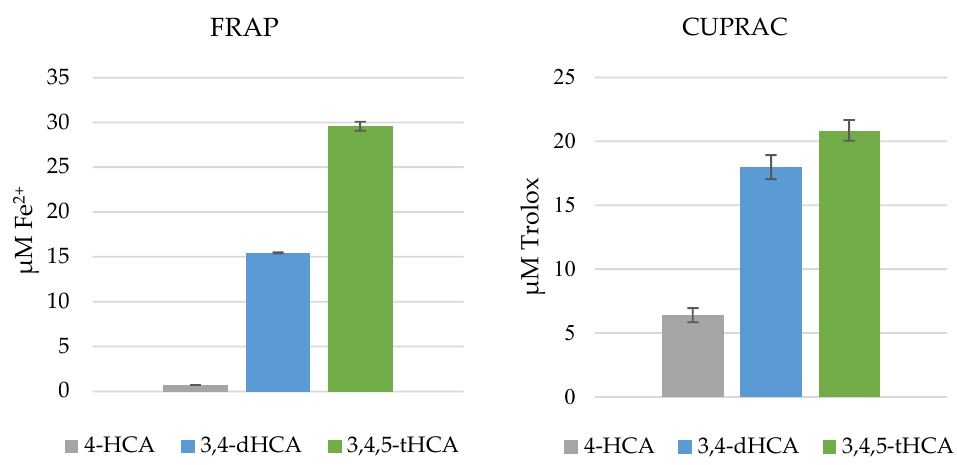
Figure 9. Reducing activity of CA and its derivatives, evaluated by FRAP and CUPRAC assays (the concentration of studied compounds was 0.05 mM).